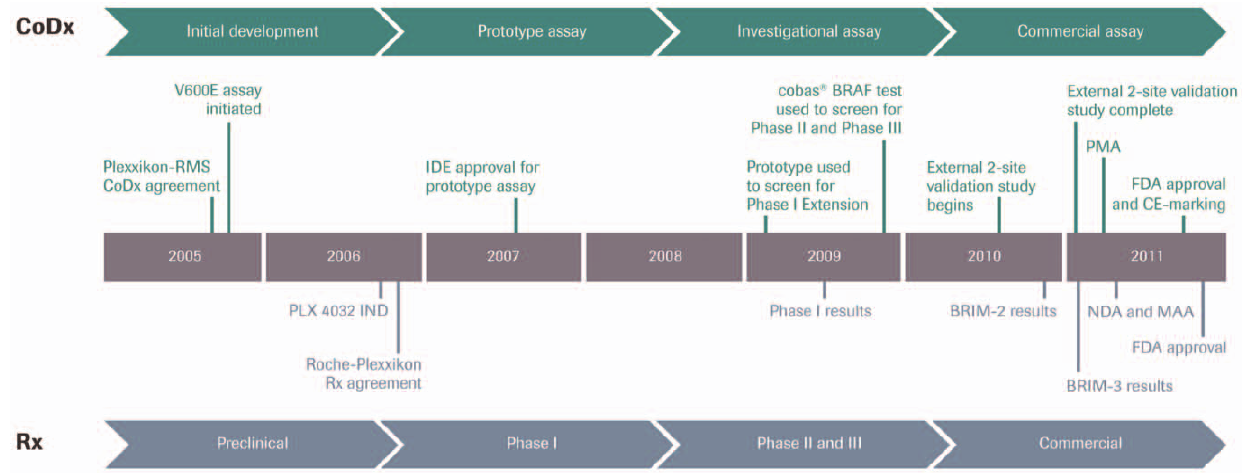
Figure 1. Key milestones in the co-development of vemurafenib and the cobas H 4800 BRAF V600 Mutation Test. Phases of companion diagnostic (CoDx) development in green, drug (Rx) development in blue. IDE=Investigational Device Exemption; IND=Investigational New Drug Application; MAA=Marketing Authorisation Application; NDA=New Drug Application; PMA=Premarket Approval Application; RMS=Roche Molecular Systems, Inc.